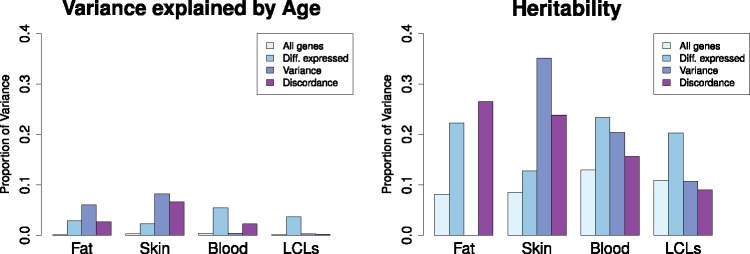
Median proportion of variance explained by age (left) and genetics (right) in all tested genes (All genes), differentially expressed genes with age (diff. expressed), genes changing variance with age (Variance) and genes discordant in MZ twins with age (Discordant). In general, the amount of variance explained by age and heritability in genes significantly affected by age in different ways is larger than in the median of the whole genome. The exception applies to those groups of genes with very little number of genes, like discordance genes in fat with 1 gene. The complete variance decomposition analysis is shown in Supplementary Material, Table S4.